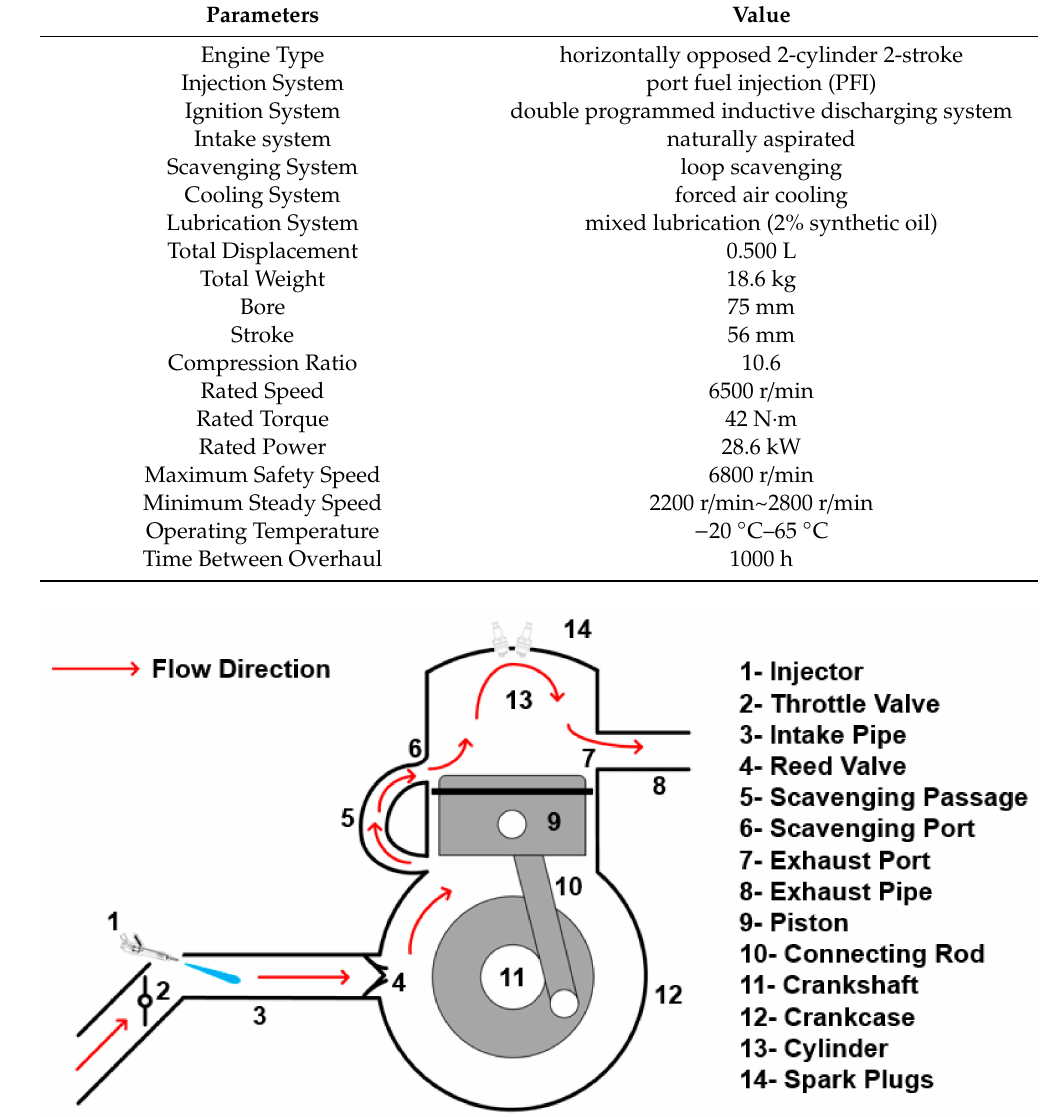
Figure 3. Schematic diagram of the initial prototype